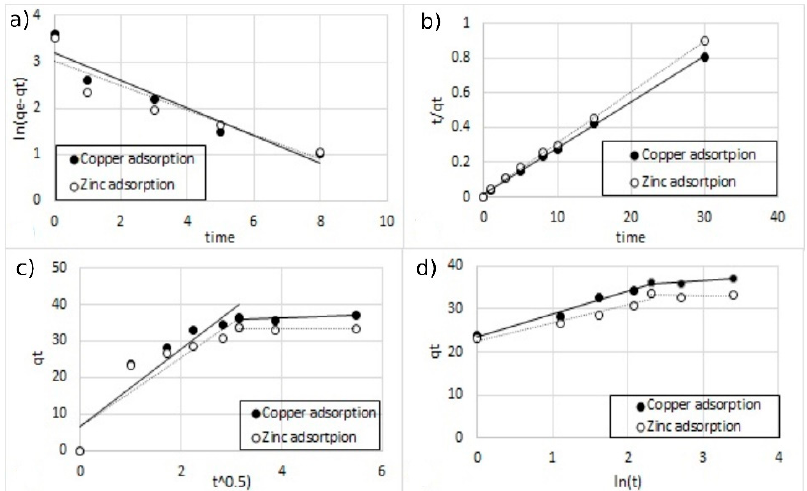
Figure 16. The fitting of different kinetic models for double-ion adsorption (Cu 2+ and Zn 2+ ) onto MA functionalized with 5% of coating, ( a ) pseudo-first-order, ( b ) pseudo-second-order, ( c ) Elovich model, and ( d ) intra-particle diffusion model.